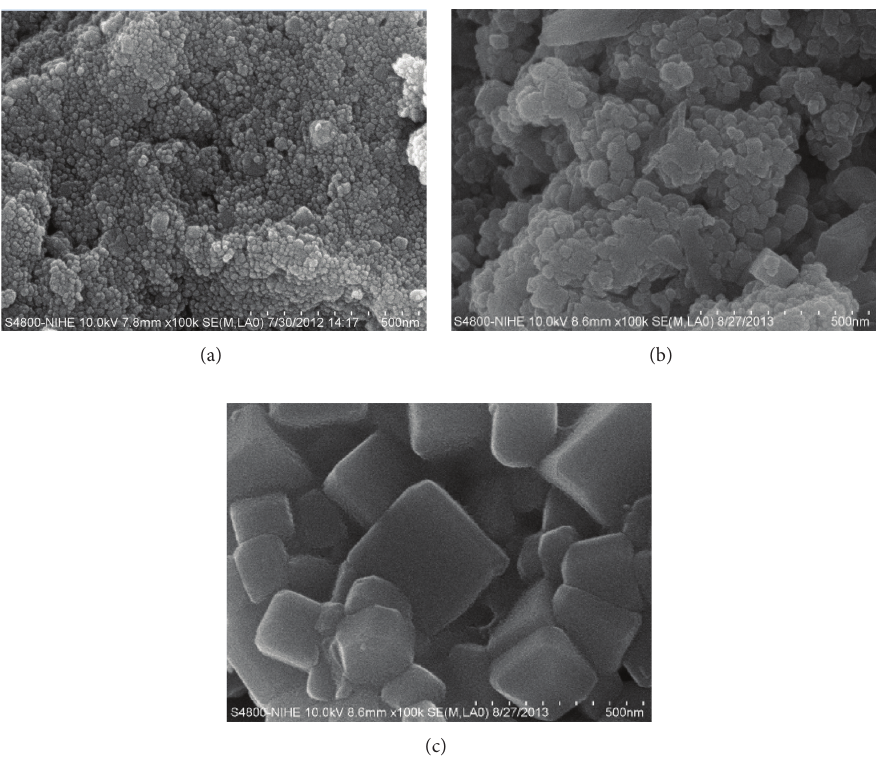
Figure 7: FE-SEM images of (a) as-milled (K 0.5 Na 0.5 )NbO 3 and samples calcined at (b) 700 and (c) 1000 ∘ C for